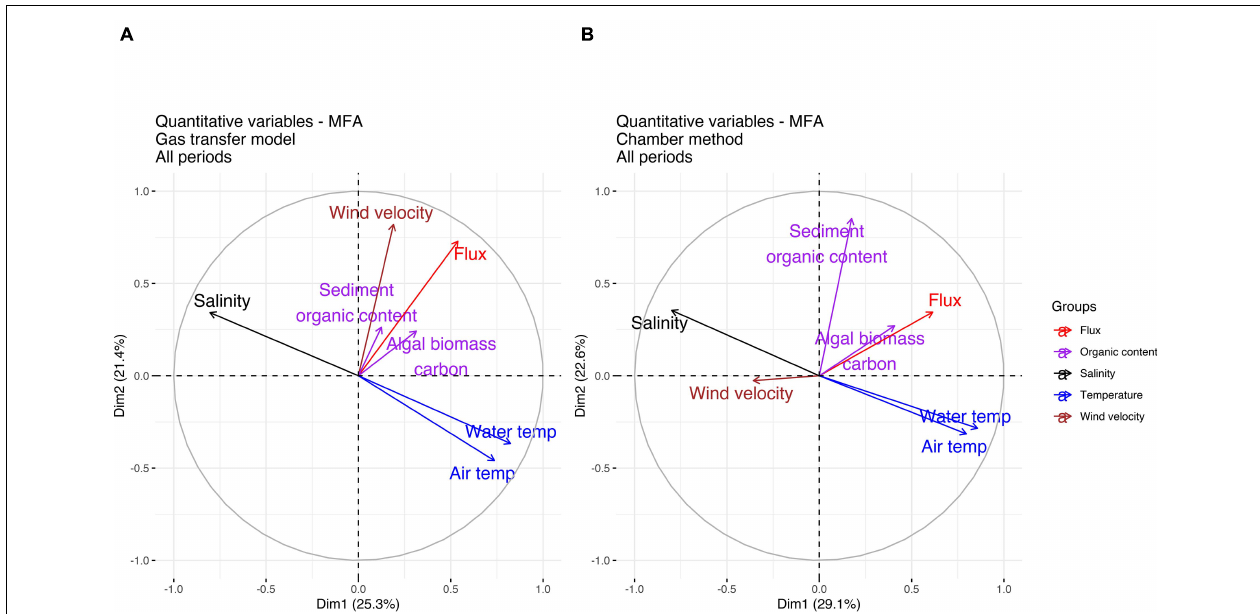
FIGURE 9 | Multiple factor analysis (MFA) for all sampling periods showing weighted correlations between CH 4 flux and environmental forcing factors for the gas transfer model (A) and the chamber method (B)